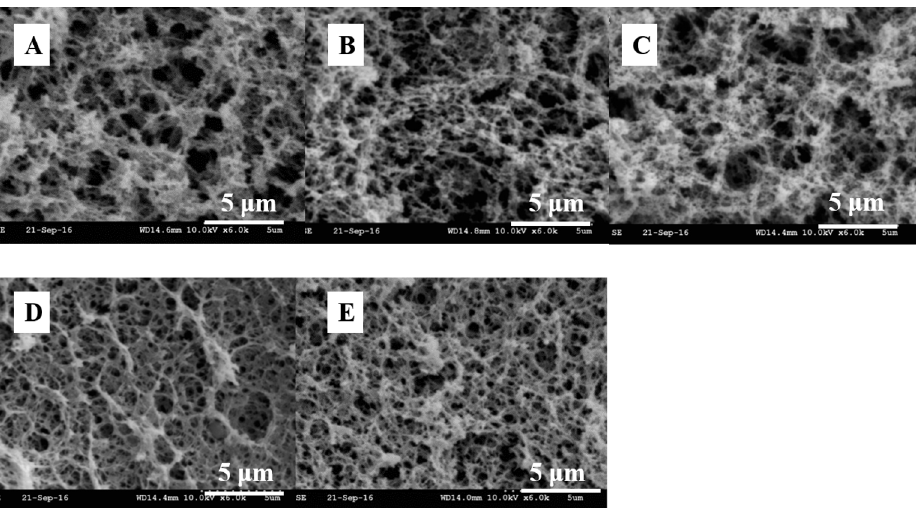
Figure 1. SEM microstructure of MPs gels induced by different combinations of pressure and heating; scale bars are 5 µ m. ( A ). 0.1 MPa, 75 ◦ C, 30 min; ( B ). 200 MPa, 20 ◦ C, 30 min, then 0.1 MPa, 75 ◦ C, 30 min; ( C ). 400 MPa, 20 ◦ C, 30 min, then 0.1 MPa, 75 ◦ C, 30 min; ( D ). 200 MPa, 75 ◦ C, 30 min; ( E ). 400 MPa, 75 ◦ C, 30 min. This figure was cited from reference